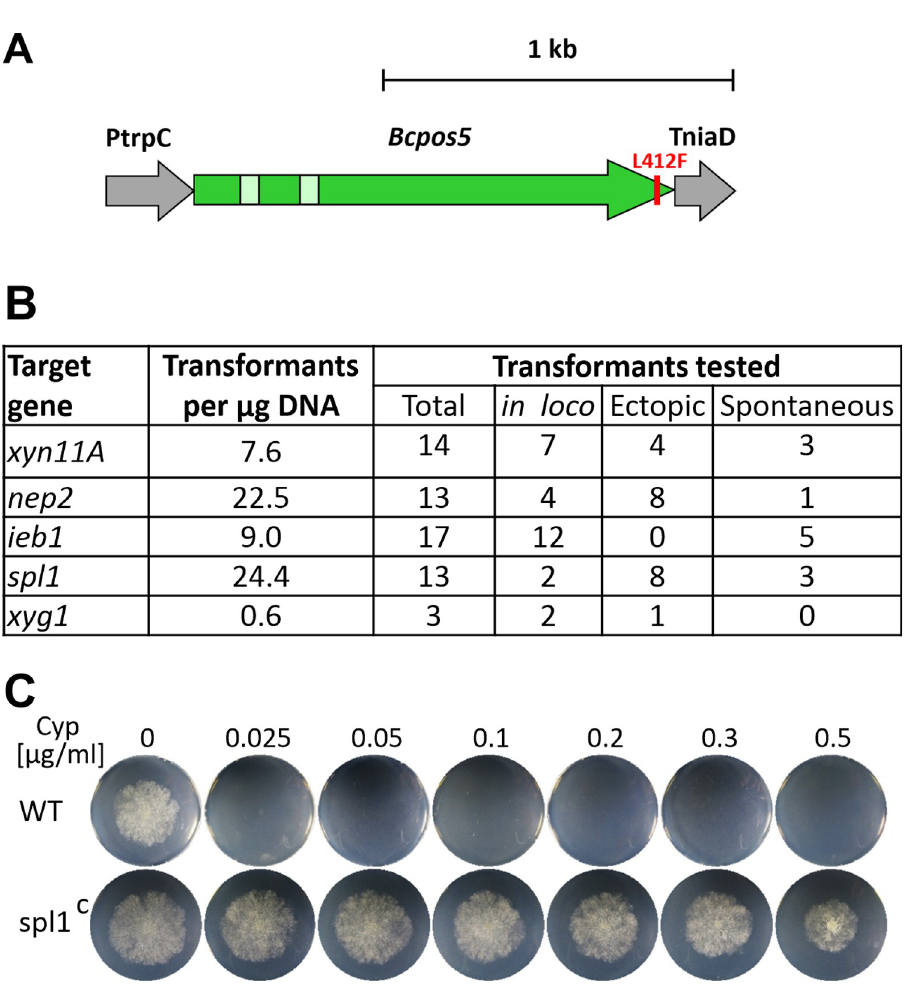
Fig 1. Establishment of cyprodinil resistance (CypR) as a novel selection marker for B . cinerea . A: Schematic picture of a CypR cassette containing a resistant variant of Bcpos5 gene due to the L412F amino acid exchange. PtrpC: Aspergillus nidulans trpC promoter fragment. TniaD: B . cinerea niaD terminator fragment. B: Transformation efficiency with the CypR cassette and characterization of the CypR transformants. in loco : Correct knockout mutants (replacement of WT DNA by CypR cassette). Ectopic: Detection of CypR cassette outside of target gene. Spontaneous: CypR ‘transformants’ lacking the CypR cassette. C: Growth of a CypR resistant transformant (spl1 C ), and the sensitive B . cinerea WT strain on agar plates with GB5 medium with 25 mM containing different Cyp concentrations.